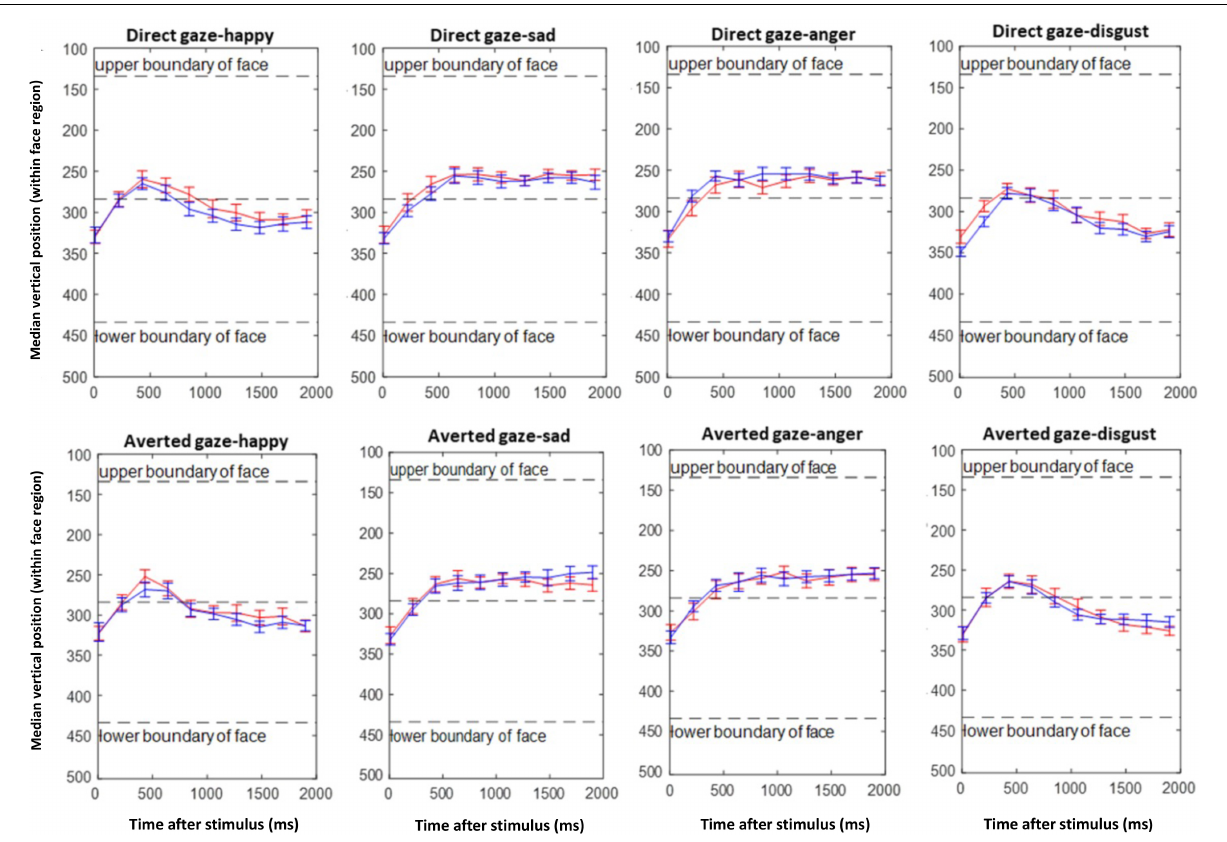
Frontiers in Human Neuroscience |